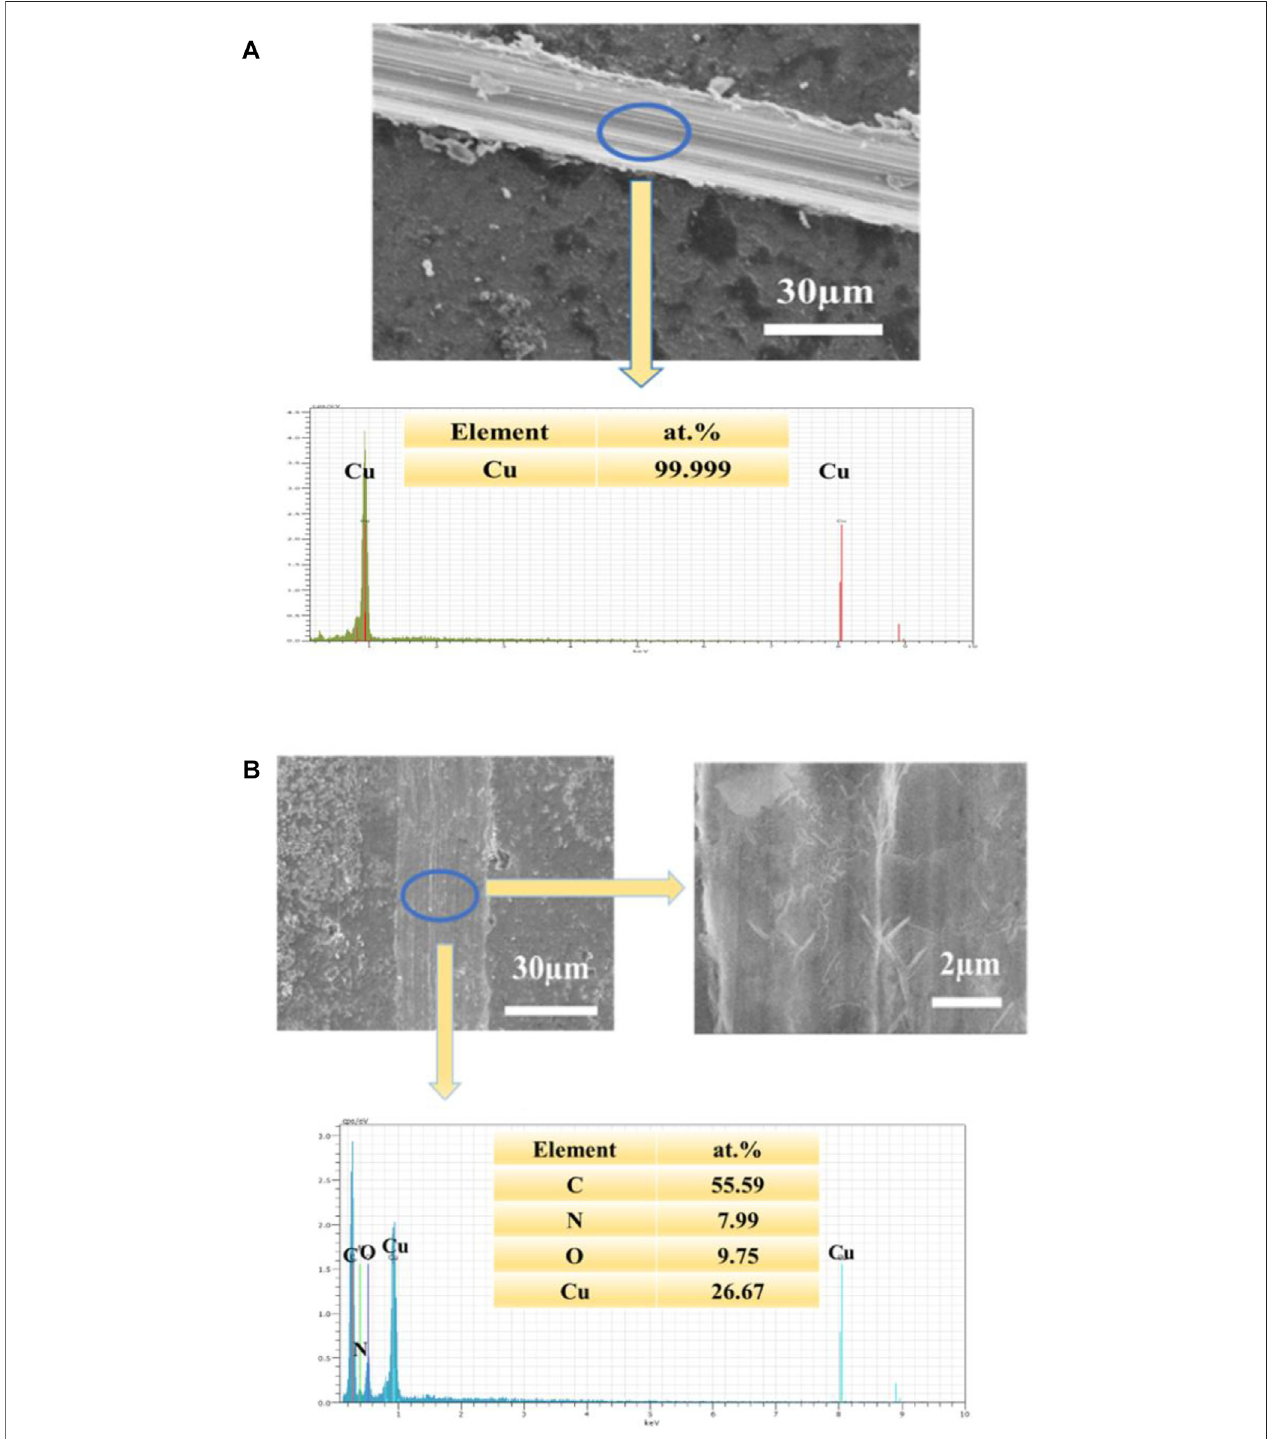
FIGURE 8 | (A) : SEM image of the scratched PDA@0.02M 8-HQ@Cu and EDS spectrogram (B) : SEM image of the scratched PDA@0.02M 8-HQ@Cu and high magni fi cation, immersed in 3.5 wt.% NaCl aqueous solution for 10 h (corrosion time) at 25 ° C, and EDS spectrogram.